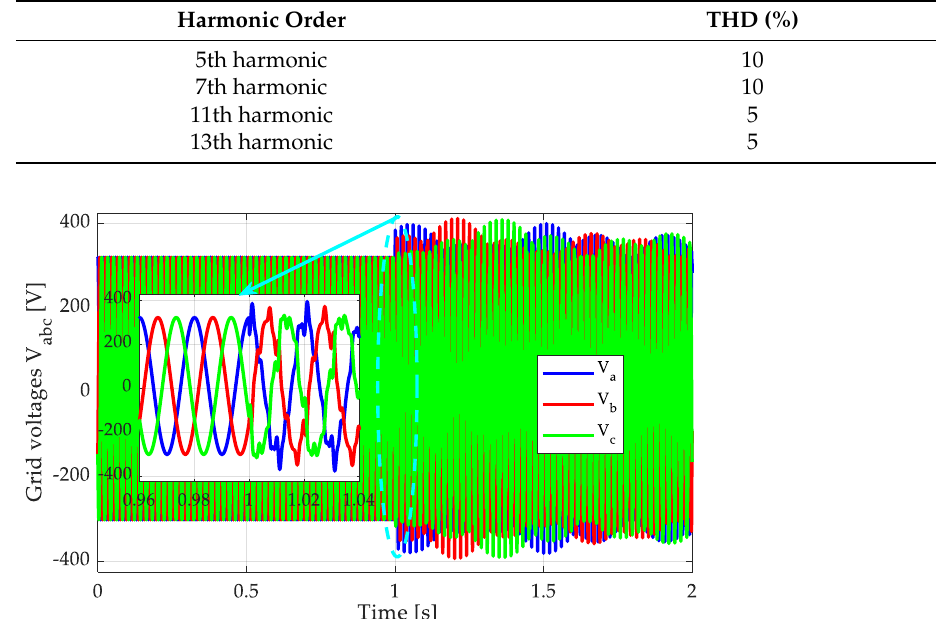
Figure 14. Estimated frequency for all studied methods.